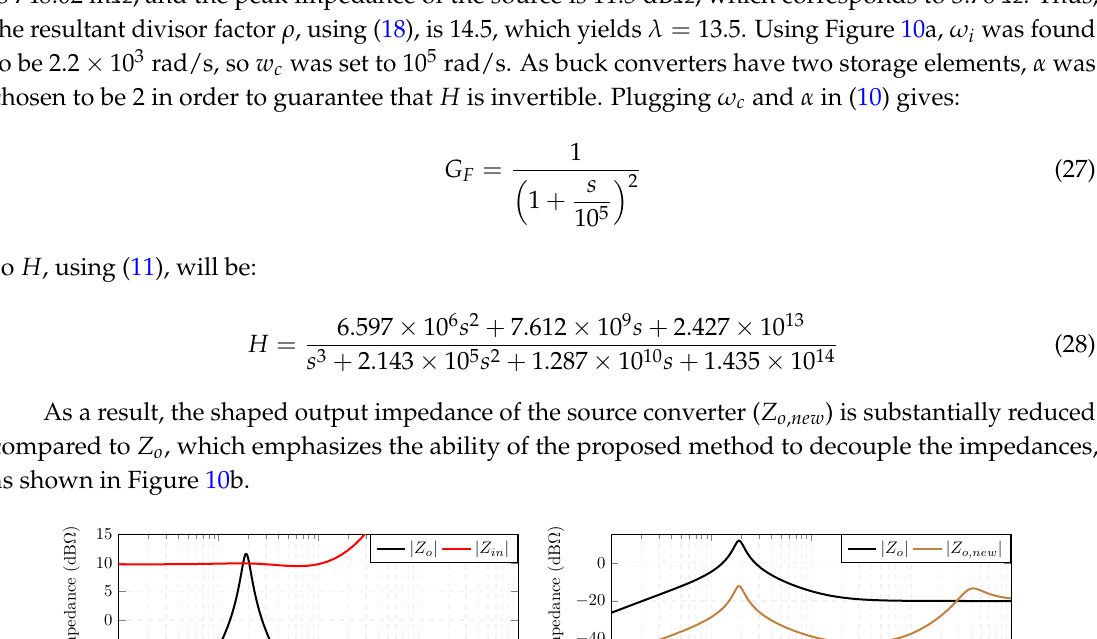
Z o with the shaped impedance | |